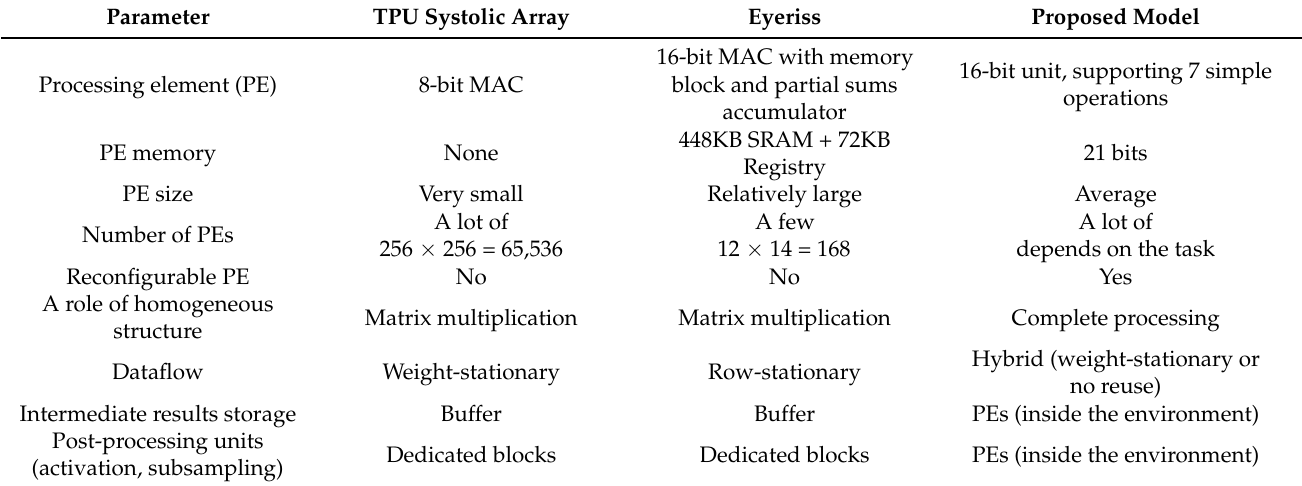
Table 1. Comparison of accelerators based on homogeneous